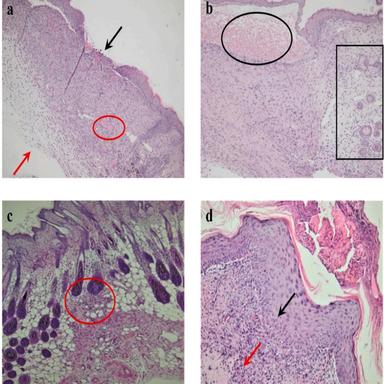
Histological examples of wound healing in murine wound model where a silicon ring was used to avoid the lateral proliferation of the cell tissue: (a) no treatment, healed naturally; in the central region of the wound area a non-continuous epidermis is seen (black arrow), thick and a multilayered appearance; dermis with inflammatory infiltrates, and small blood vessels (red circle); horizontal collagen fibrils (red arrow) (H&E, Ob. 10×); (b) treatment with hyaluronic loaded marketed cream; epidermis detached